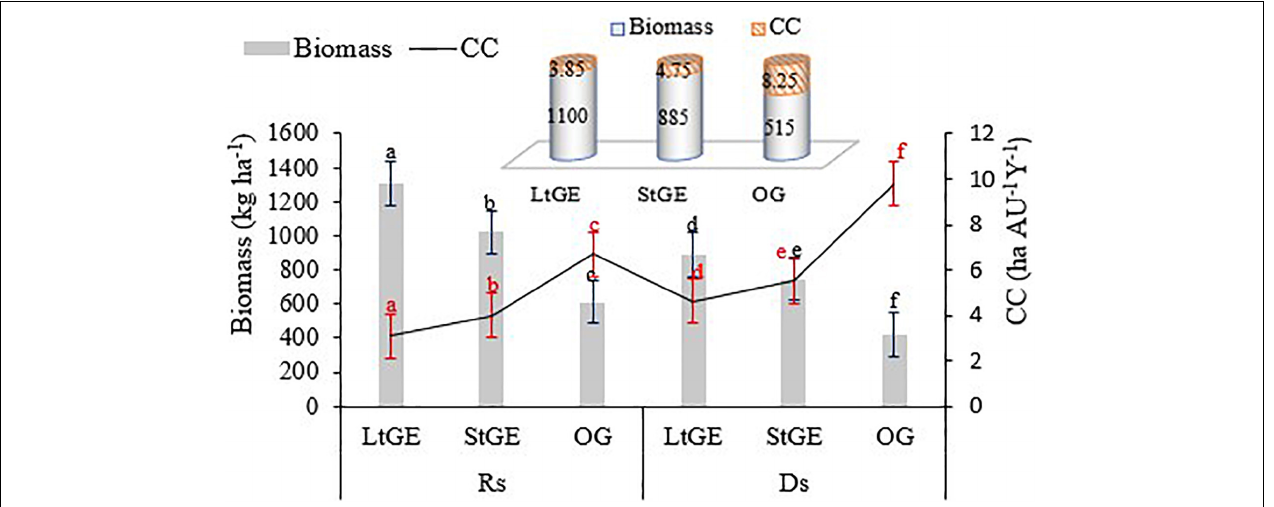
FIGURE 5 | The grass biomass and carrying capacity potential under grazing enclosure and open-grazing conditions. Note. LtGE, long-term grazing enclosure; StGE, short-term grazing enclosure; OG, open-grazing; Rs, rainy season; Ds, dry season; CC, carrying capacity. Bar and line plots show seasonal variations and cylinder plots attached show the yearly average value. Error bars are shown by standard error. Different lowercase letters within bar and line plots indicate differences with a significant level ( P < 0.05) between the treatments.